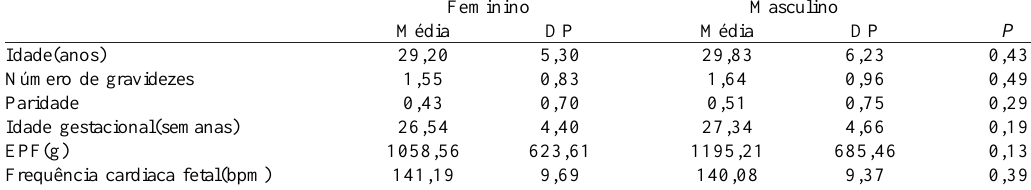
fetal entre fetos masculinos e